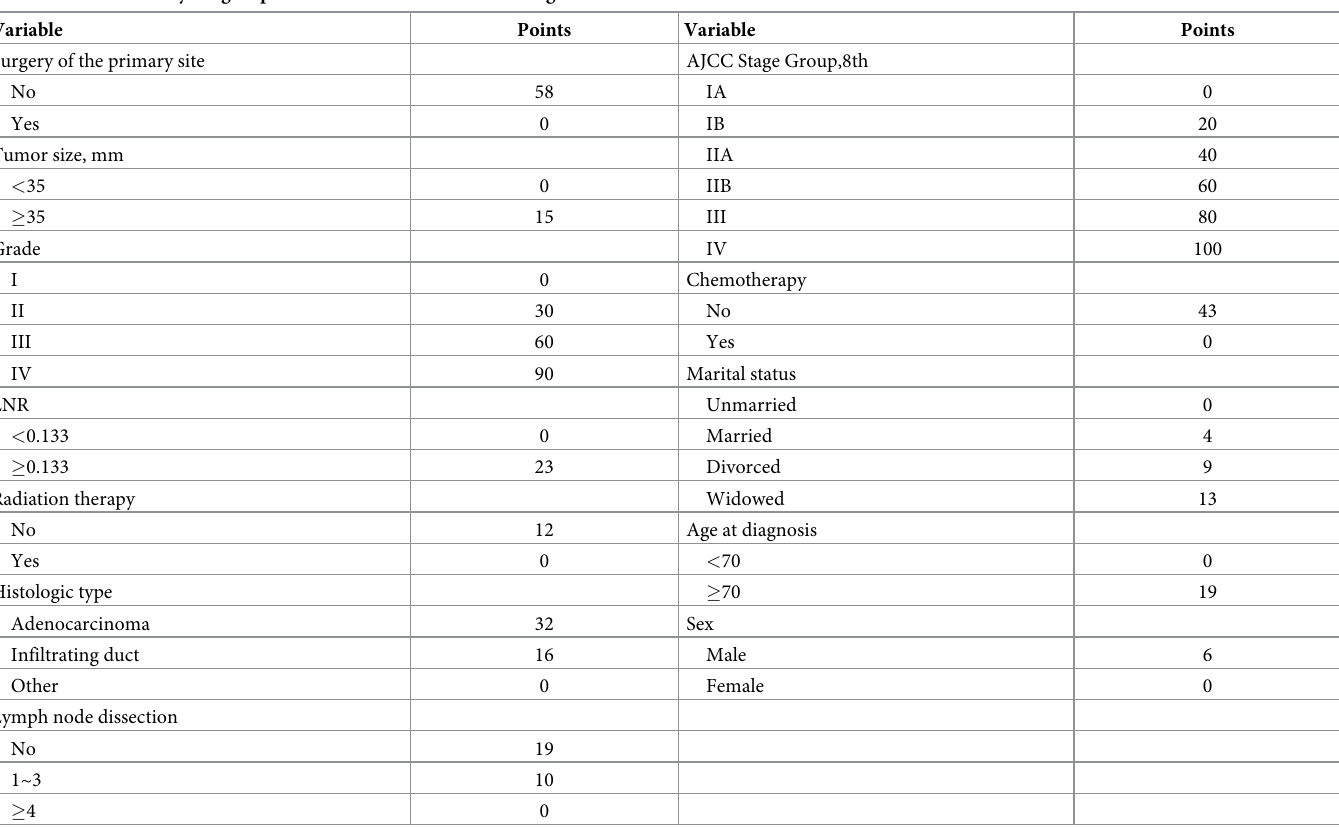
Table 3. Scores of every subgroup within each variable in the